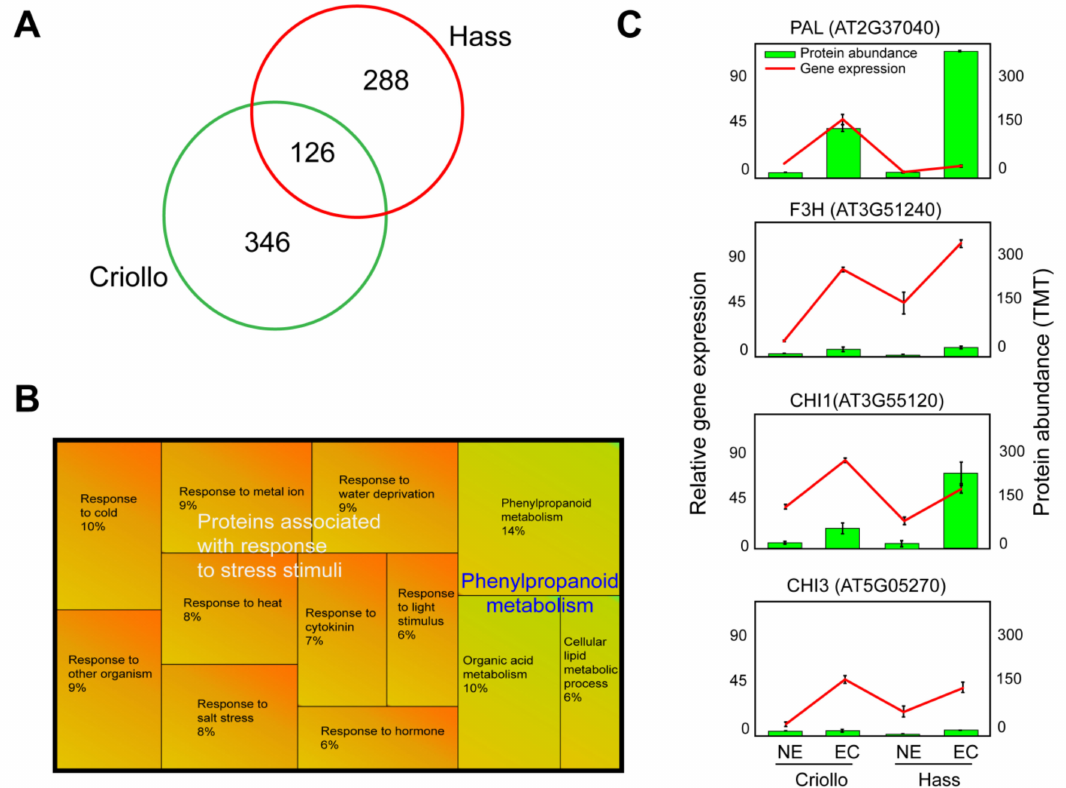
Figure 2. Di ff erentially accumulated proteins identified by comparing embryogenic (EC) vs. non-embryogenic (NEC) cultures from Hass and Criollo avocado varieties. ( A ) The Venn diagram displays the number of di ff erentially expressed proteins identified in Hass and Criollo cultures by comparing EC vs. NEC. ( B ) Core proteome representation-based gene ontology enrichment and clustering of biological process annotation (Data S2, C ). Correlation between relative gene expression and protein abundance. The gene expression was normalized using Rubisco as an internal control. Points denote the mean fold expression as compared to the control ± three replicates of EC and NEC cultures of avocado cultivars “Hass” and “Criollo”. Phenylalanine ammonia-lyase 1 ( PAL , AT2G37040), flavanone 3-hydroxylase ( F3H , naringenin 2_oxoglutarate 3-dioxygenase, AT3G51240), Chalcone flavonone isomerase 1 ( CHI1 , AT3G55120), probable chalcone-flavonone isomerase 3 ( CHI3 ,